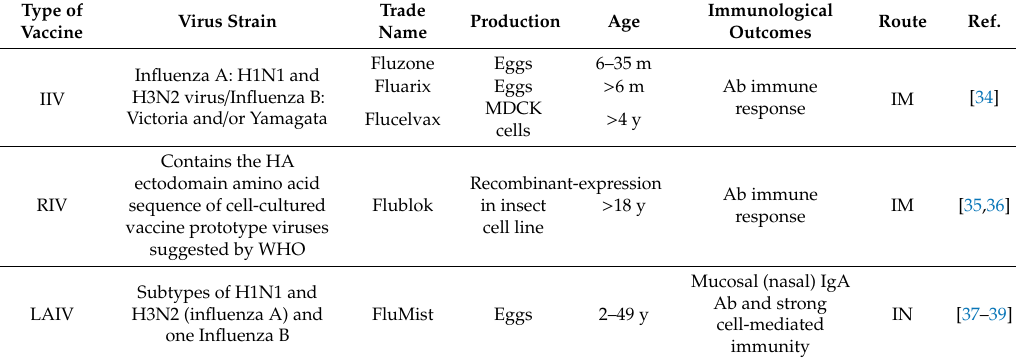
Table 1. Categories of annual influenza vaccines approved by the Food and Drug Administration